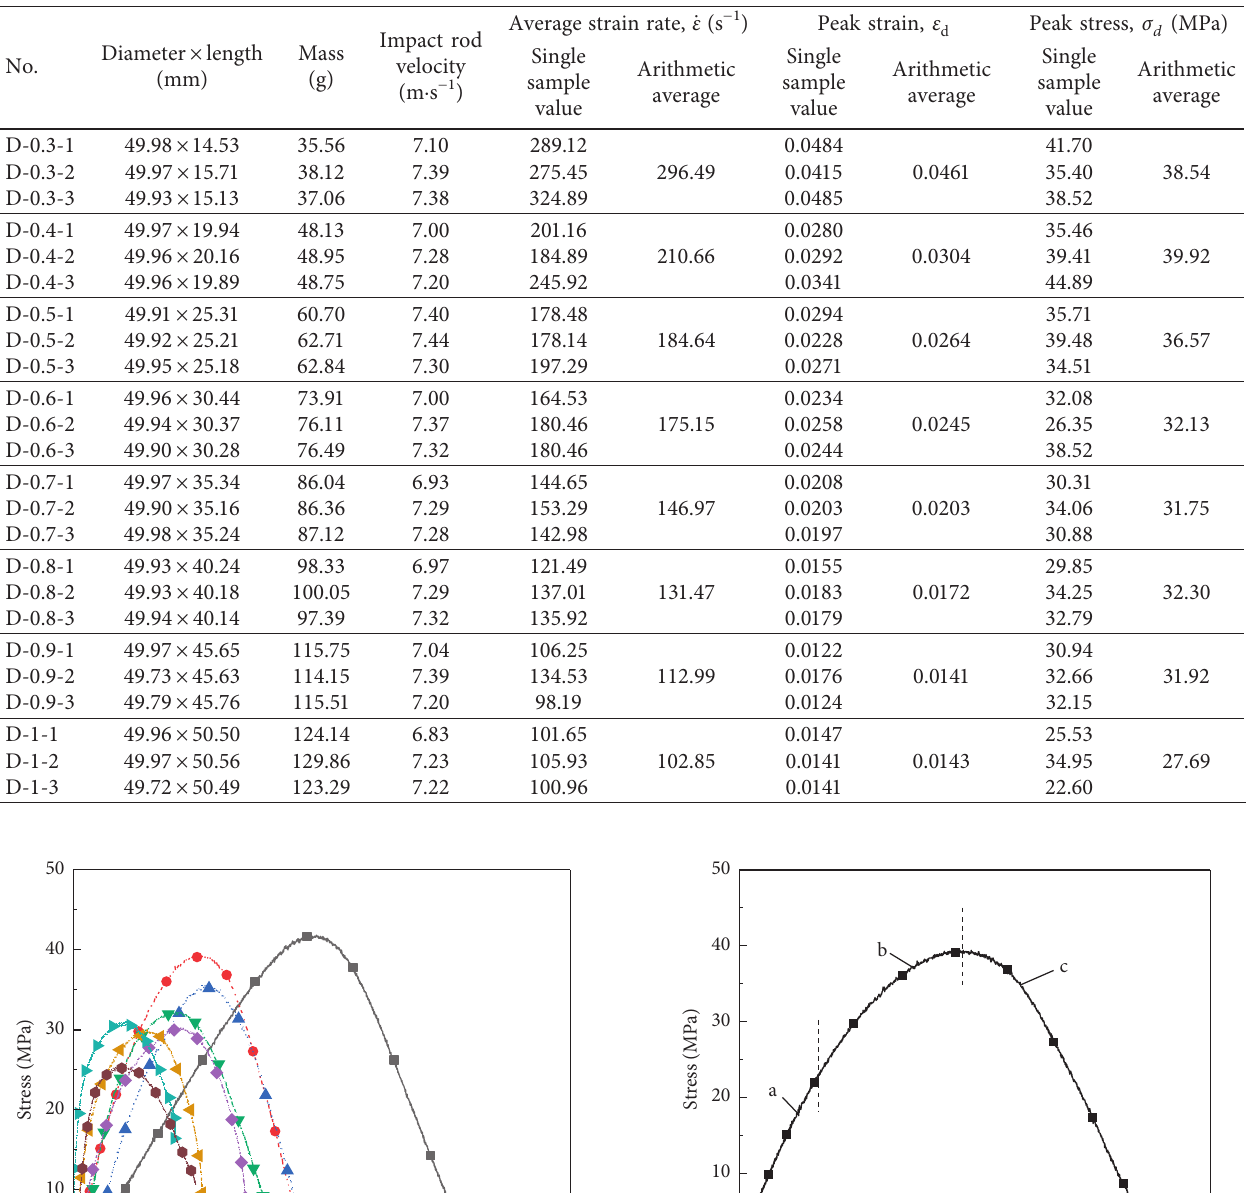
Table 1: Variation in the coal dynamic deformation behavior with the L / D ratio.